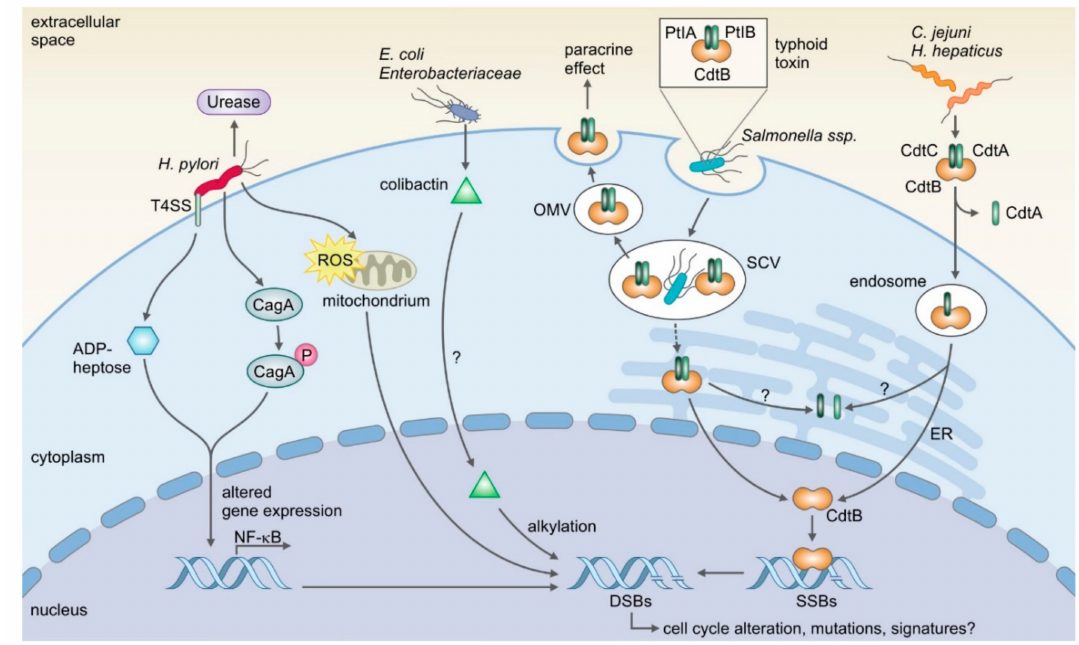
Figure 2. Overview of microbes and their specific virulence factors that can induce DNA damage. H. pylori’s type IV secretion system (T4SS) is known to be crucial for induction of DNA damage. The injected e ff ectors ADP-heptose and CagA alter gene expression, which leads to the expression of NF- κ B target genes and DNA damage. Additionally, production of reactive oxygen species (ROS) is believed to be a cause for DNA damage. E. coli and other Enterobacteriaceae produce the